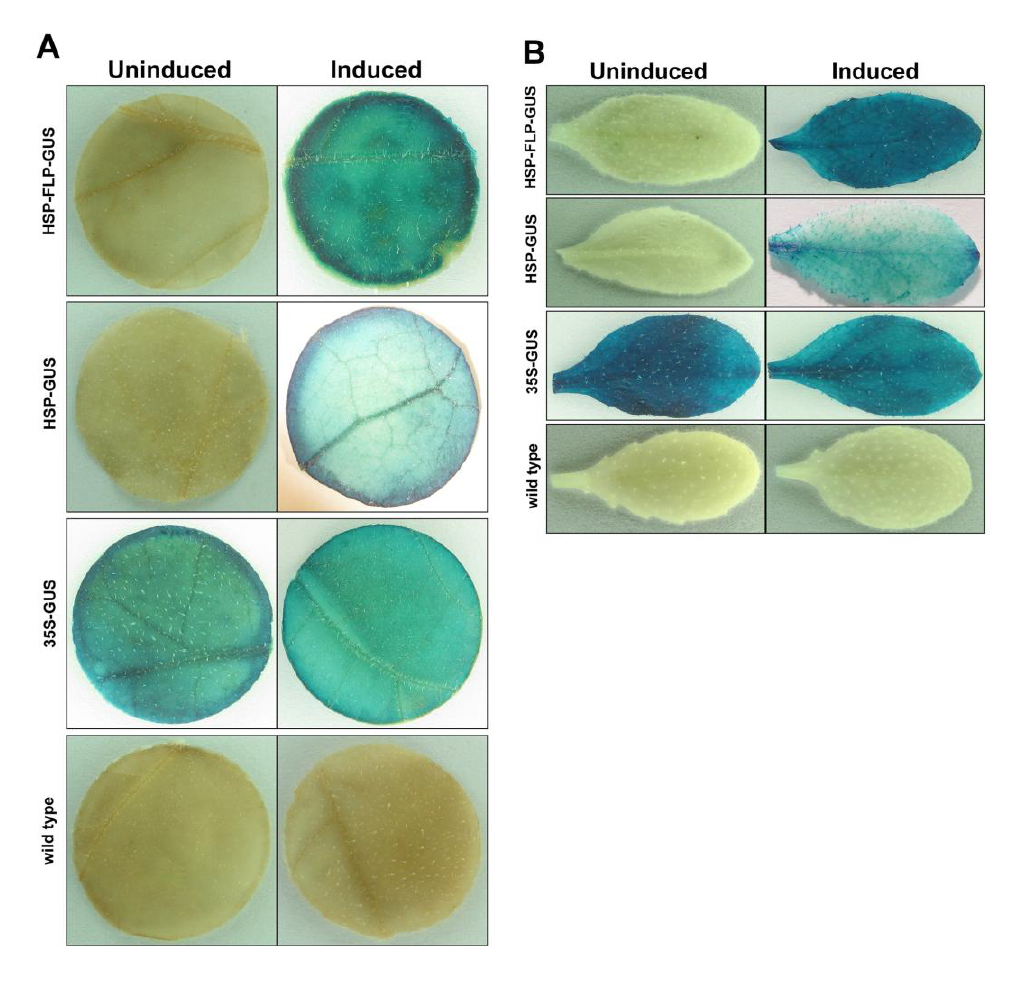
Figure 3. Histochemical analysis of GUS expression in leaf tissues of tobacco (A) and Arabidopsis (B) plants exposed to heat-shock at 42 °C for 6 h. HSP-FLP-GUS (transgenic containing FLP/FRT recombination system); HSP-GUS (transgenic control: heat-shock promoter driving GUS expression); 35S-GUS (transgenic control: CaMV 35S promoter driving GUS expression); wild type (non-transgenic